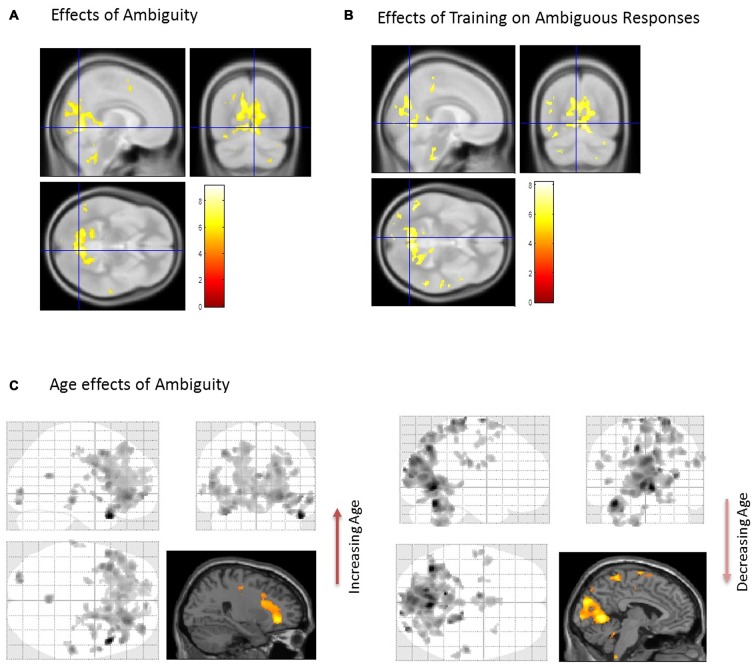
Brain activations associated with the perception of ambiguous stimulus. (A) When comparing Ambiguous and non-Ambiguous stimuli the overall effect was seen with a group peak activation in the R Lingual [6 −68 −4] (p < 0.05, family wise error (FWE) corrected). (B) Comparison of ambiguous stimuli before (Block 1) and after training (Block 3). When comparing the two ambiguous blocks (1 and 3) to measure the effect of the “biasing” block. Here, similar regions in parietal and visual cortices predominated with significant effects also observed in the right anterior temporal cortex (p < 0.05 FWE corrected, Table 1). (C) Using the regions differentially active to ambiguous vs. non-ambiguous stimuli as a mask (A) we then found activations that positively correlated with age in anterior regions (Right orbitofrontal and anterior temporal lobe, top image, p < 0.001, uncorrected, Table 1). In contrast regions negatively correlated with age were observed posteriorly (cluster peaks in lingual gyrus and precuneus, bottom image, p < 0.001, uncorrected, Table 1). For extracting our ROIs, application of F-contrasts as inclusive masks and these regions were present at p < 0.05, FWE corrected (image not shown).